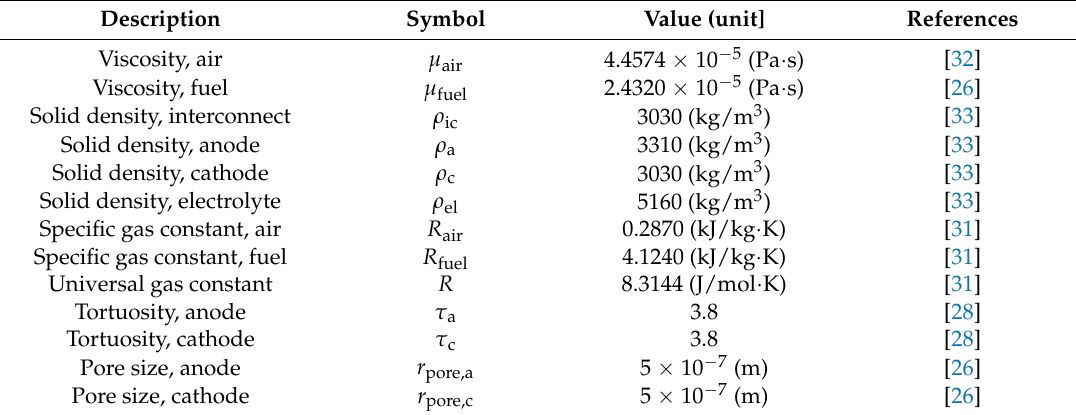
Table 5. Material properties.